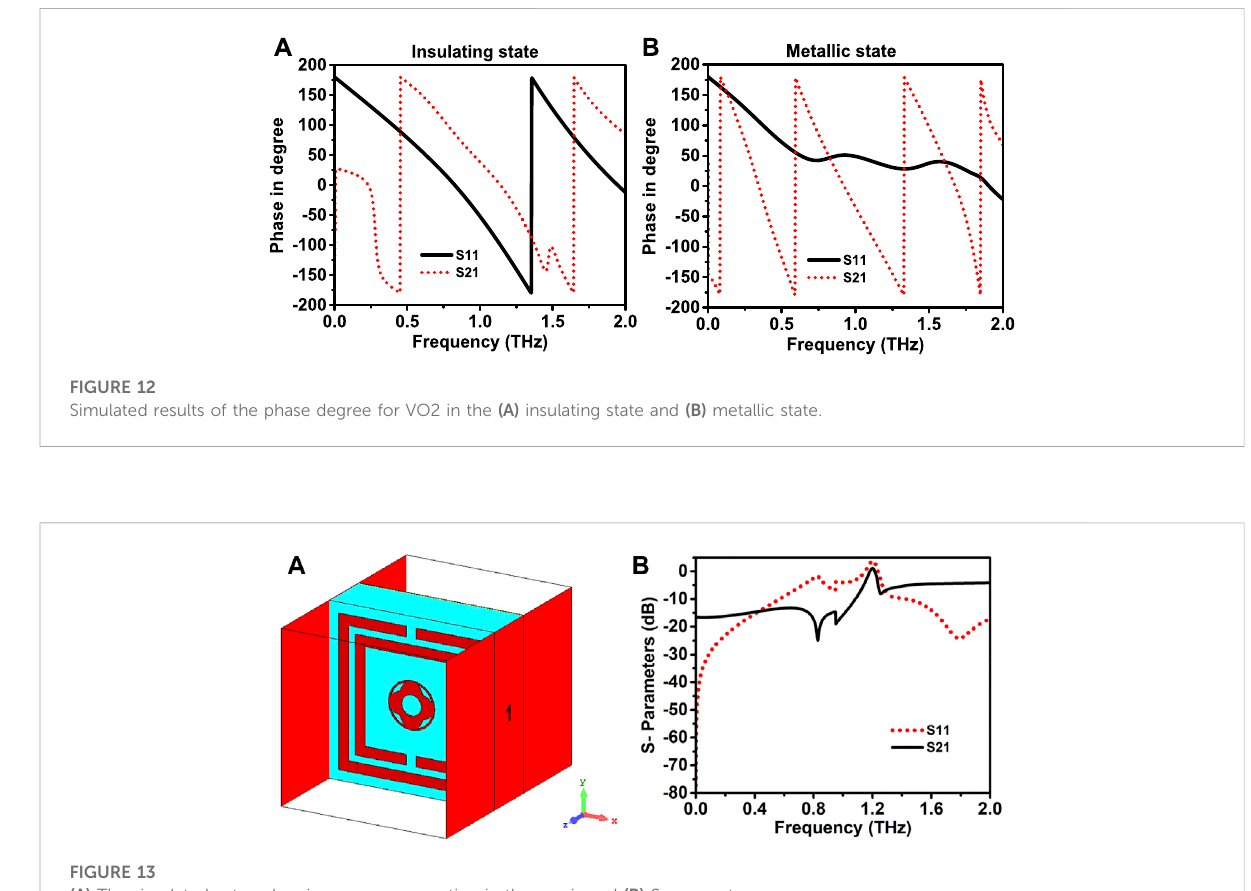
unique design of the proposed structure, a polarization and limited incident angle independency was achieved. The stable absorption characteristics con fi rmed the incident angle